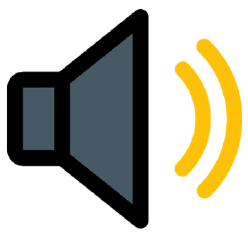
Fig. 6. Voice message indicator (source: